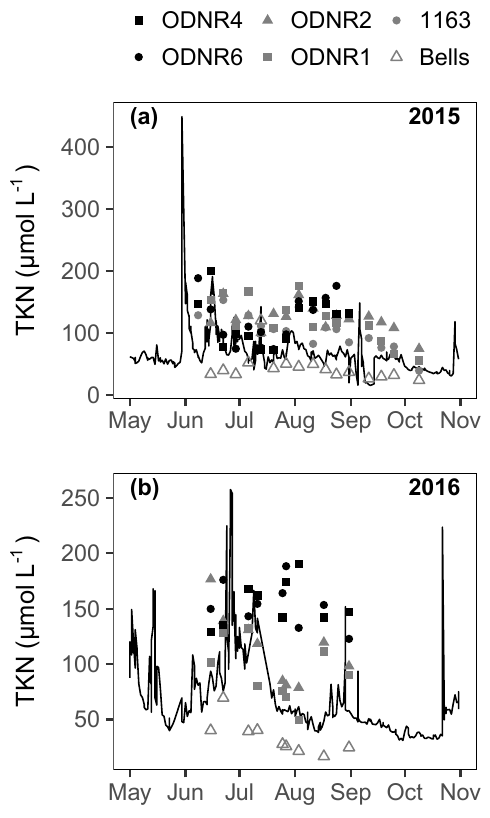
Figure 3. Total Kjeldahl nitrogen (TKN) concentrations in the San- dusky River (line) and in Sandusky Bay (symbols) in (a) 2015 and (b) 2016. Note the difference in y axis scales between panels (a) and (b) .